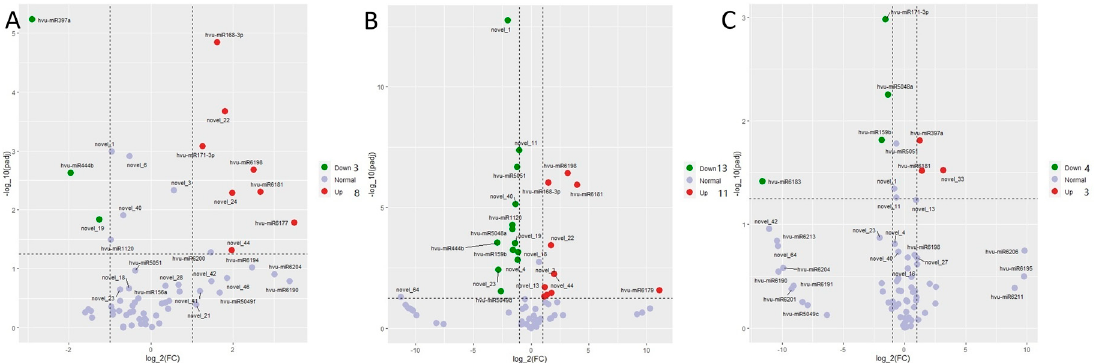
Figure 2. Volcano plots of colonization-associated, differentially expressed miRNA in barley. ( A ) Bar- ley differentially expressed miRNA identified by comparing reads from colonized roots at 3 dai vs. mock. ( B ) Barley differentially expressed miRNA identified by comparing reads from colonized roots at 7 dai vs. mock. ( C ) Barley differentially expressed miRNA identified by comparing reads from colonized roots at 7 dai vs. 3 dai. The dashed line in the figure shows the set threshold, vertical line (x = ± 1) and horizontal line (y = 2). Genes with padj values less than 0.05 and absolute values of foldchange greater than 2 are generally considered as differential